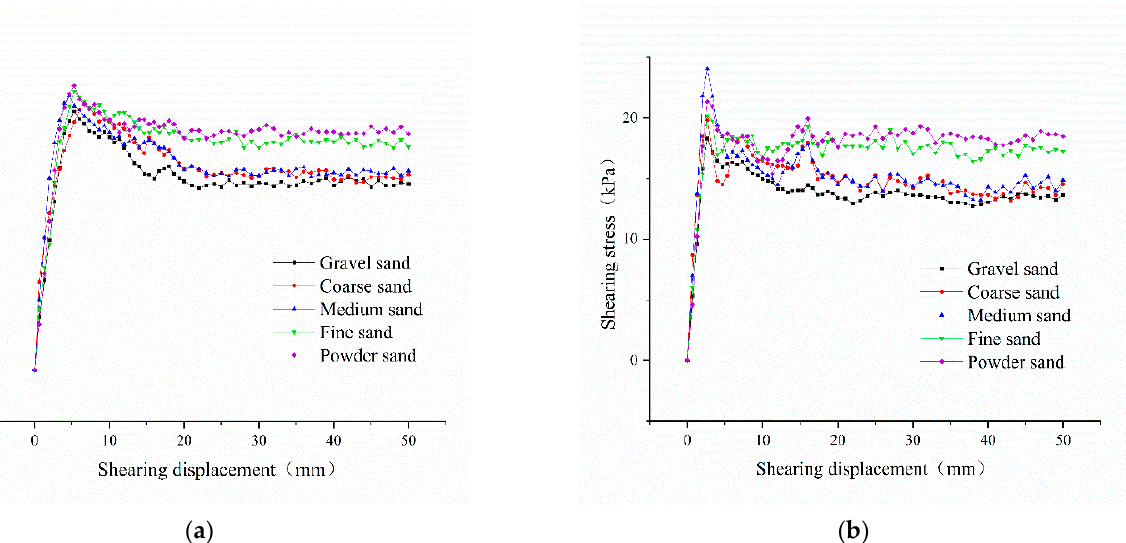
Figure 3. Shear stress-displacement of sand with different particle sizes. ( a ) No slurry lubrication; ( b ) Slurry lubrication.